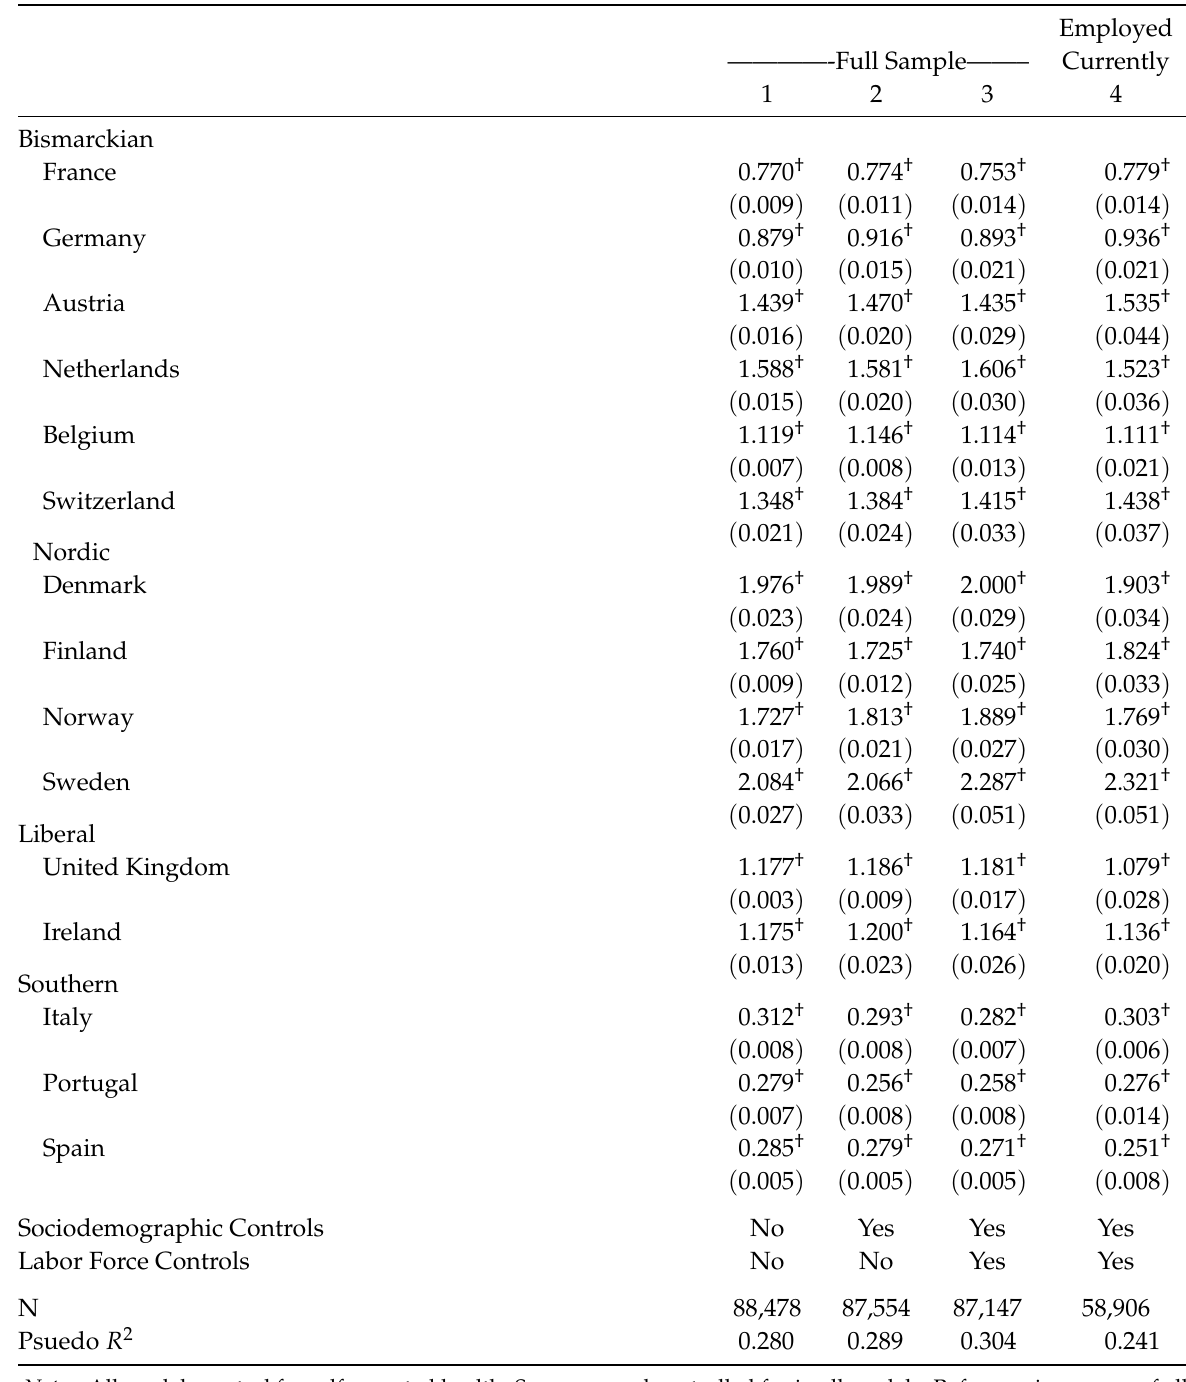
Table 2: Logistic Models Predicting Self-Reported Disability of Working Age Population by Country of Residence